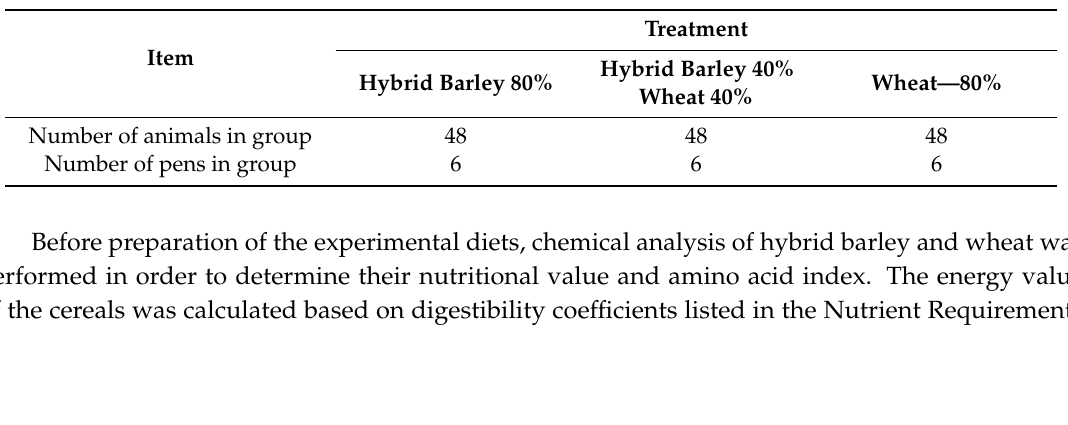
Table 1. Design of